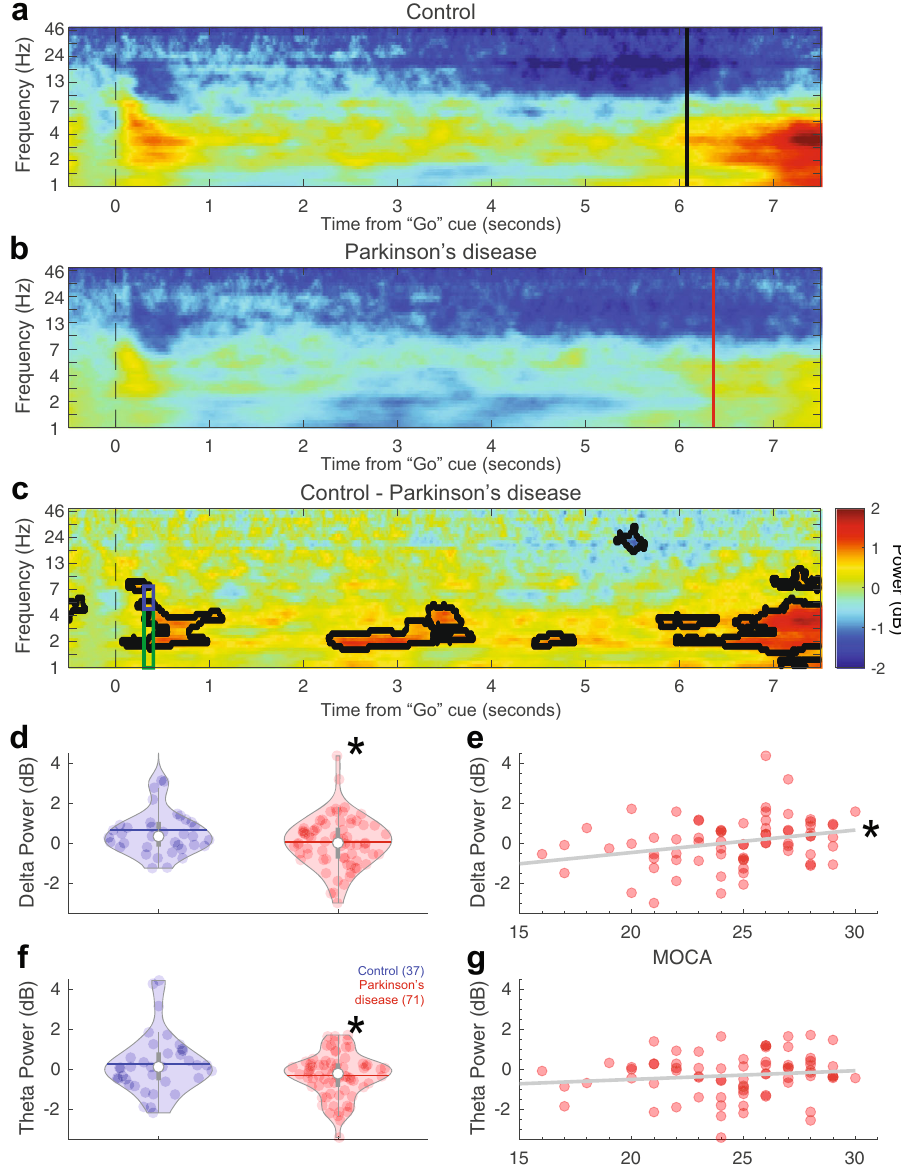
Fig. 2 Cue-triggered midfrontal delta power predicts cognitive dysfunction in Parkinson ’ s disease (PD). Midfrontal power over time from the imperative “ Go ” cue from a control and b PD participants on 7-s trials from EEG electrode Cz. c Comparison of control and PD patients. Areas outlined by solid black lines indicate P < 0.05 via a t test of activity in control compared to PD participants. There was signi fi cantly less d cue-triggered midfrontal delta power (1 – 4 Hz, time-frequency-region-of-interest (tf-ROI): green box) and f cue-triggered midfrontal theta power (4 – 7 Hz, tf-ROI: blue box) in controls vs. PD patients. e Delta power predicted cognitive dysfunction as measured by MOCA in PD patients, but g theta power did not. * P < 0.05. Data from control ( n = 37) and PD ( n = 71) (300 – 400 ms after cue, 1 – 4 Hz control: 0.7 + / − 0.2 dB, PD: 0.0 + / −